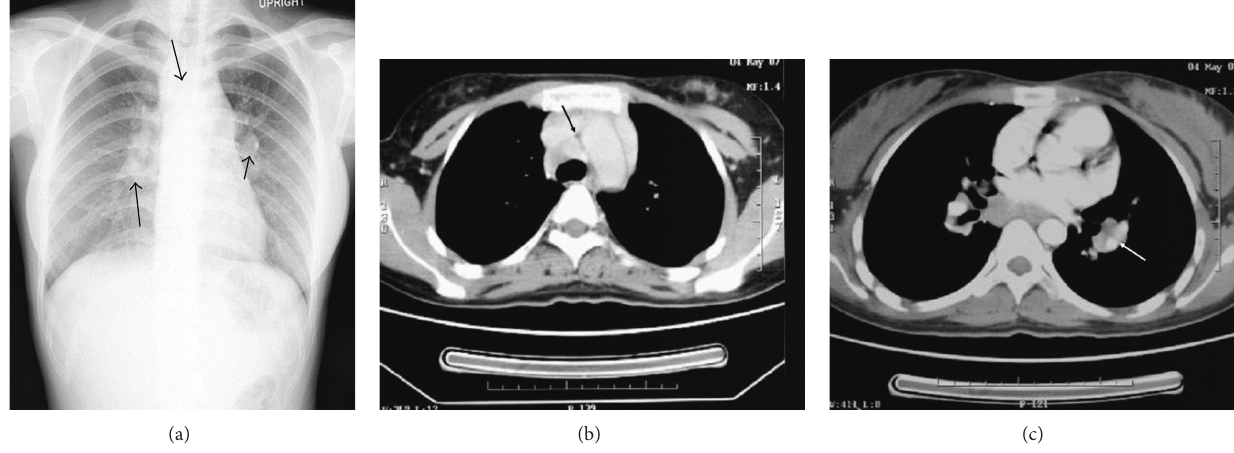
Figure 2: (a) Film chest PA showing widening mediastinum (5.9 cm), bilateral hilar enlargement sizes 2.1 × 6.4 cm and 2.9 × 6.2 cm. Arrows point to mediastinal nodes and both hilar nodes. The lung parenchyma was normal. (b) and (c) CT with contrast showing paratracheal nodes, subcarinal nodes, and bilateral hilar nodes.